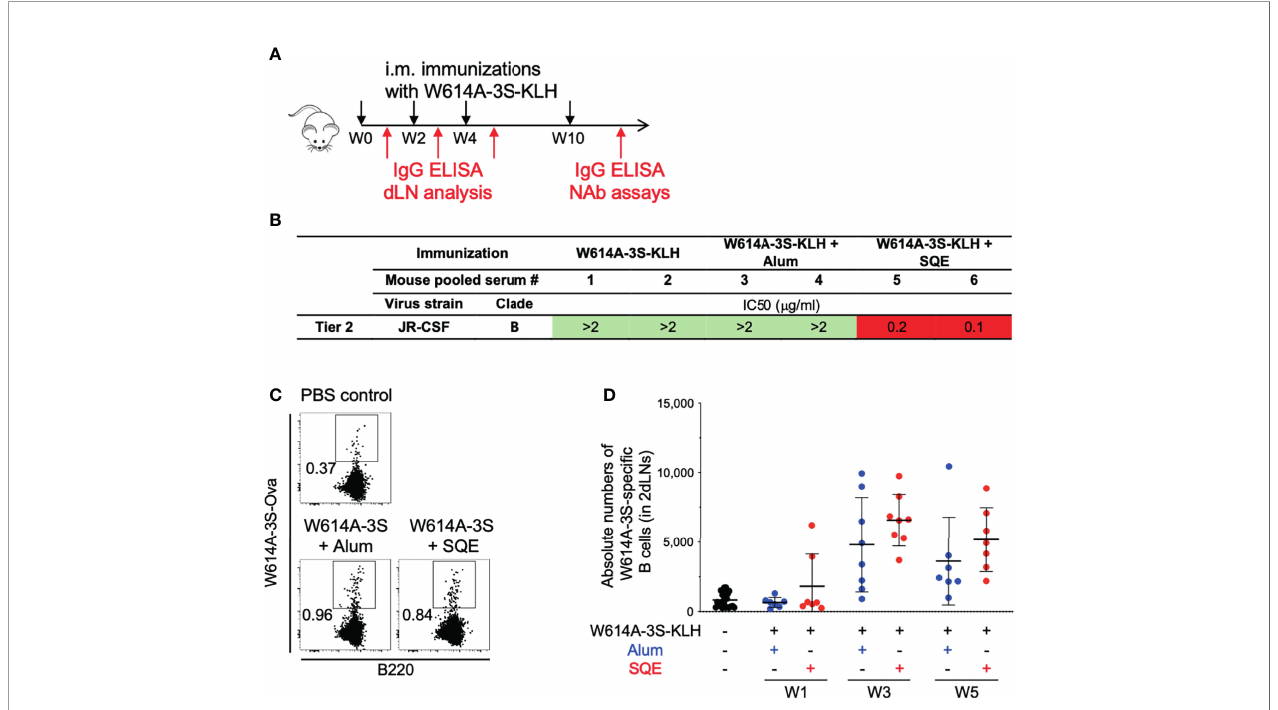
FIGURE 2 | Validation of neutralizing Abs in mouse models and detection of W614A-3S-speci fi c B cells. (A) Experimental schedule of mouse immunizations and biologic samples. Animals were vaccinated with W614A-3S-KLH carrier non-adjuvanted, adjuvanted with Alum or SQE at Week 0 (W0), W2, W4, and W10 (black arrows), and blood samples were collected or draining lymph node (dLN) analysis was made after each injection (red arrows). (B) Neutralizing IC50 of serum-puri fi ed W614A-3S-speci fi c IgG was evaluated at W11 against Tier 2 virus JR-CSF strain. Puri fi ed peptide-speci fi c IgG was obtained by pooling sera of 4 – 5 mice for each condition. Color codes of neutralization assay (IgG m g/ml): green, >2; orange, 1.9-1; and red, <0.9. (C) Representative dot plots of W614A- 3S-speci fi c B cells in dLNs after three immunizations with PBS (PBS control) or W614A-3S-KLH adjuvanted with Alum or SQE. Numbers represent peptide + cell percentages of B cells. (D) A dot plot with mean ± SD (n = 7 – 23) represents the absolute numbers of W614A-3S-speci fi c B cells in two dLNs, 1 week after fi rst (W1), second (W3), and third (W5) immunizations with PBS (black), W614A-3S-KLH adjuvanted with Alum (blue) or SQE (red). Statistical analyses were carried out using the Mann – Whitney U